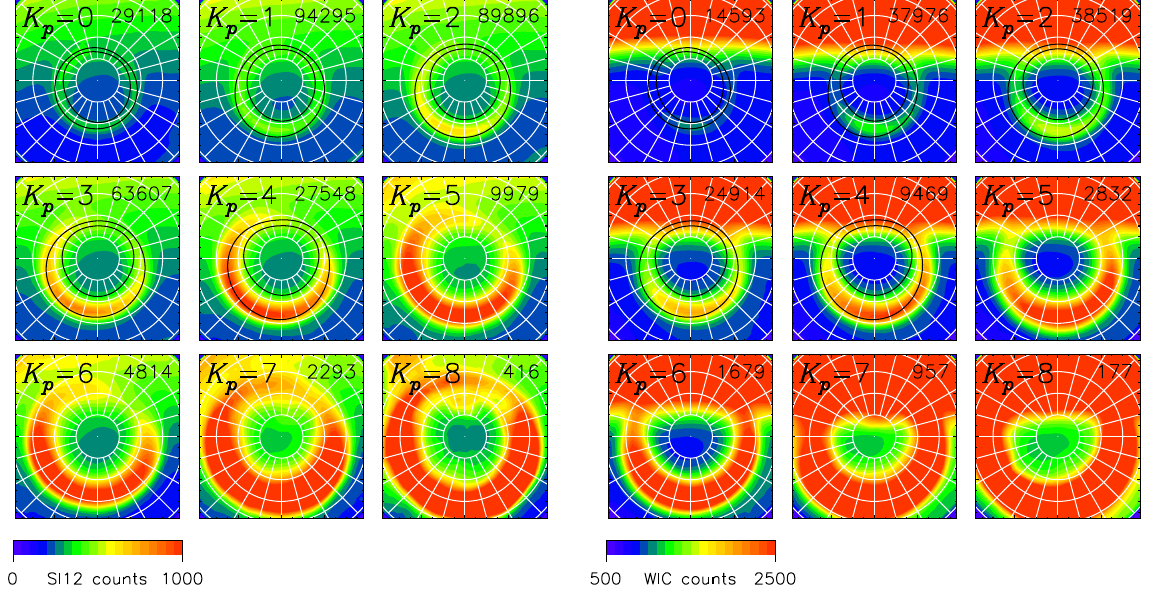
Fig. 1. Averaged SI12 (left) and WIC (right) observations of the Northern Hemisphere aurorae (observing period 2000 to 2002) parameterized by K P , presented in a polar geomagnetic latitude and MLT frame, with local noon to the top of each panel. Concentric circles mark latitudes in 10 ◦ steps, while radial white lines indicate MLT meridians. For K P 6 4 the appropriate Feldstein and Starkov (1967) average auroral oval is superimposed. The number in the top right of each panel indicates the number of individual images that were combined to produce the average. Elevated counts at the dayside are the result of